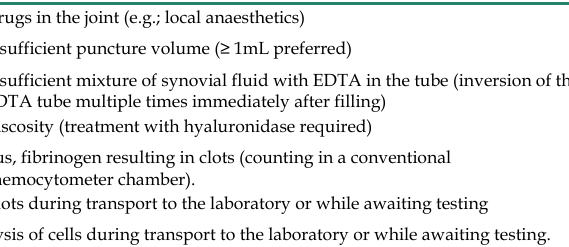
Table 1 . Factors potentially influencing the results of cell count and differential result in synovial fluid.